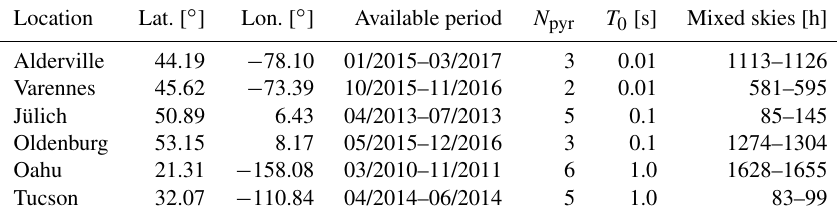
Table 2. Details of the available clear-sky index data sets: location names and their respective latitudes and longitudes, the available record- ing periods, number of pyranometers N pyr , original temporal resolutions T 0 , and total durations of mixed-sky conditions available for the